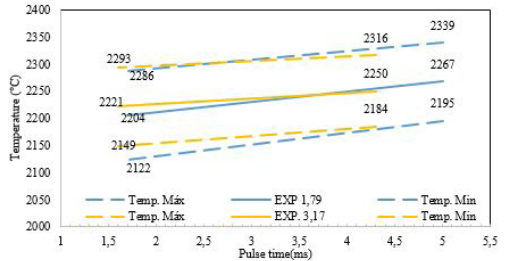
Figure 8. Droplet temperature versus pulse time.